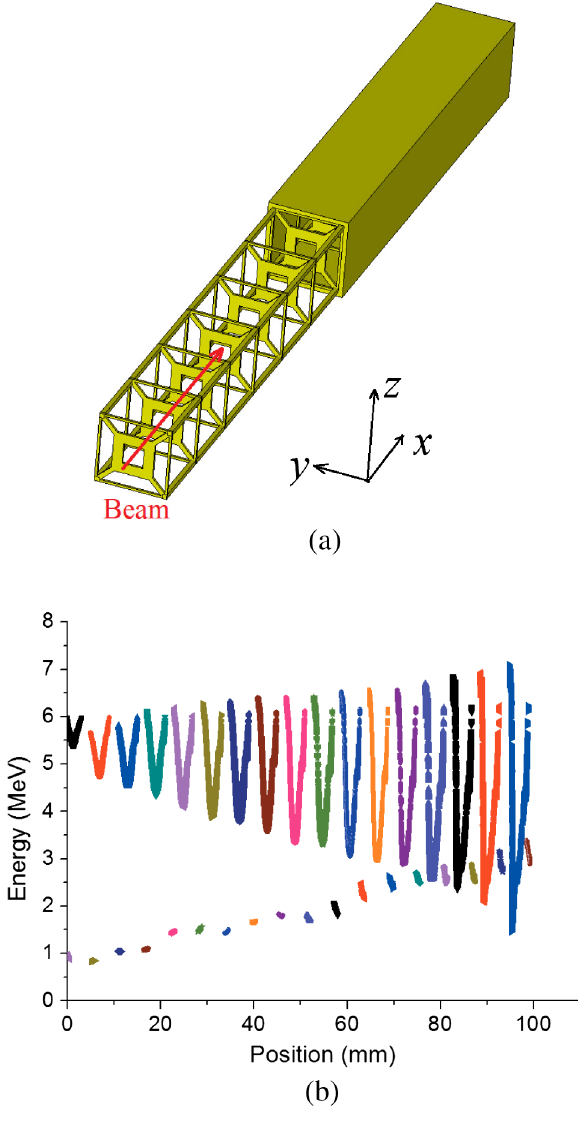
(b) Phase space evolution in the x direction of the drive bunch (the top group) and the witness bunch (the bottom group). The time interval between every two snapshots is 0.02 ns. The plots of the two bunches at the same time are represented with the same color. The witness bunch is injected into the structure 25 mm after the drive